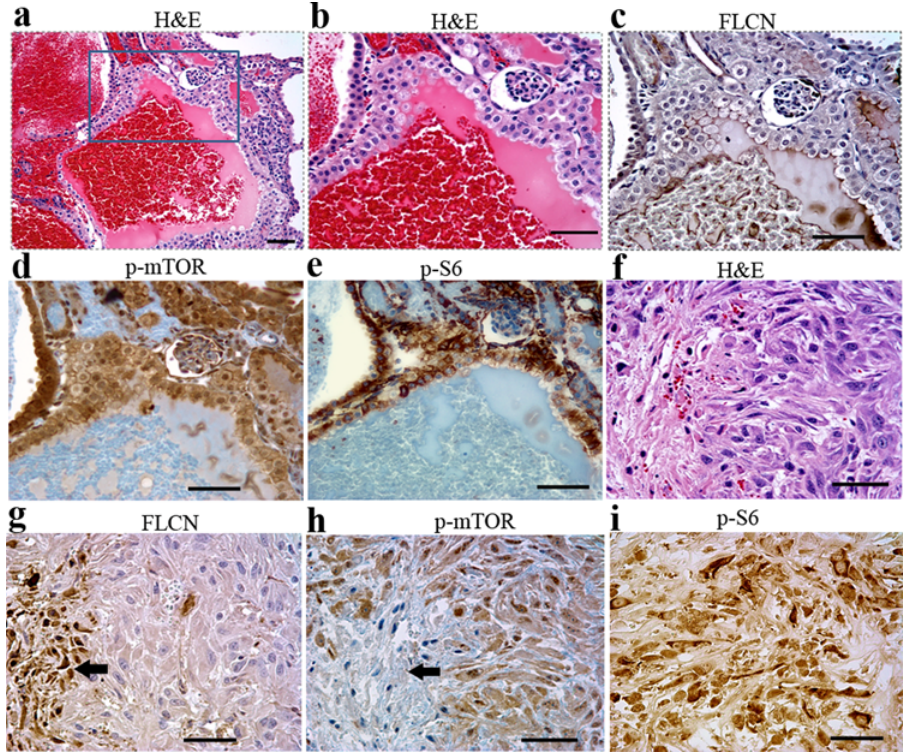
Figure 4. mTOR signaling pathway was activated in the cystic cells, cystic RCC cells. ( A ) Cystic RCC was stained by hematoxylin and eosin (H&E). (B) No FLCN expression was detected in cystic RCC, indicating deletion of the BHD gene. Phosphorylated mTOR ( C ) and phosphorylated S6 ( D ) staining was observed in the corresponding FLCN-deficient cells. Scale bar=50 m m.